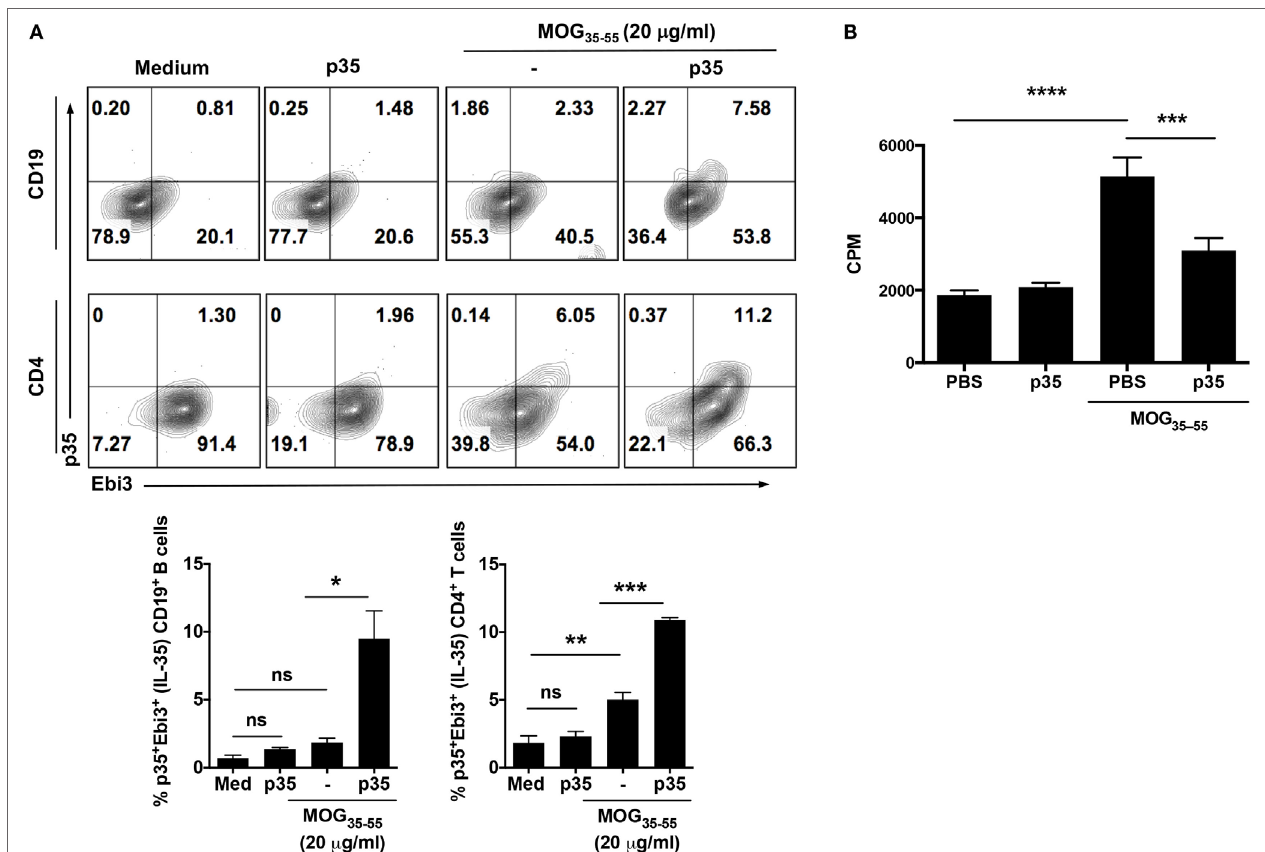
FigUre 2 | IL-12p35 induces expansion of IL-35-expressing B cells in the spleen during experimental autoimmune encephalomyelitis (EAE). (a) EAE was induced in mice by active immunization with MOG 35–55 -peptide in complete Freund’s adjuvant, and the mice were treated with IL-12p35 or PBS. Spleen cells isolated from the mice on day 17 after EAE induction were restimulated ex vivo with MOG 35–55 in presence or absence of IL-12p35 for 72 h and were analyzed by intracellular cytokine staining analysis (a) or lymphocyte proliferation assay (B) . (a) For intracellular cytokine assay, cells were gated on CD19 + or CD4 + cells, and numbers in the quadrants indicate the percentages of T or B cells expressing IL-35 (p35 and Ebi3). The data are presented as the mean ± SEM of three determinations. **** p < 0.0001; *** p < 0.001; ** p < 0.01; * p < 0.05, significantly different from PBS-treated. (B) Proliferative responses assessed by 3 H-thymidine incorporation assay were analyzed in five replicate cultures, and data presented as mean value of CPM of the five replicate cultures. Results represent at least three independent experiments. * p < 0.05, ** p < 0.01, *** p < 0.001, **** p < 0.0001 [Student’s t -test